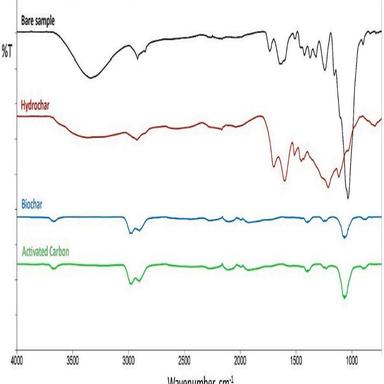
FTIR spectra of samples obtained at each stage of the production of activated carbon from the starting raw material (hemp).